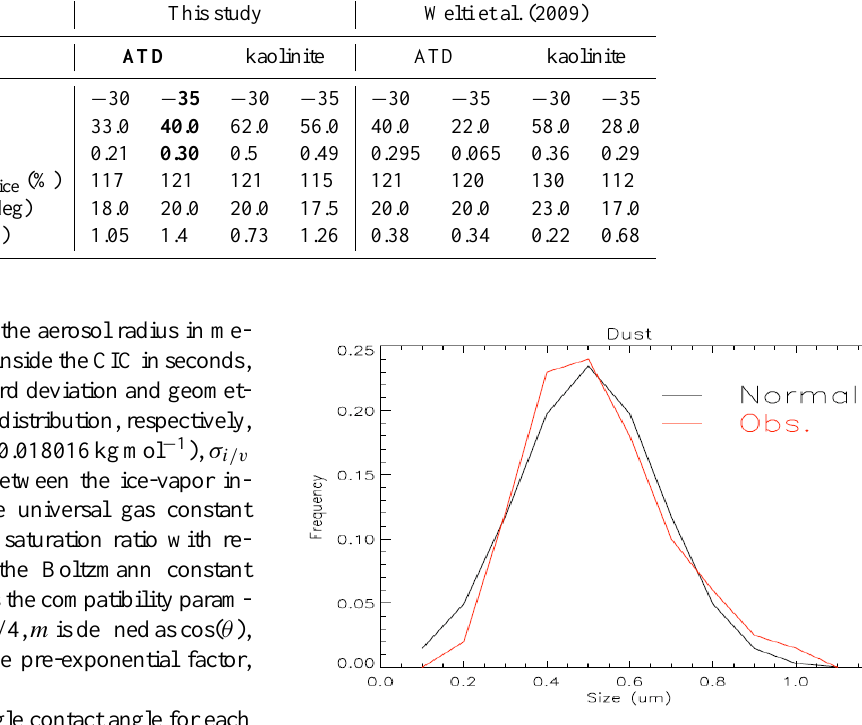
Fig. 3. The normalized size distribution observed in Cziczo et al. (2006) (red) and the fitted normal distribution used in the model simulations (black). The integrated dust number concentration, N 0 , is 10.7L − 1 .